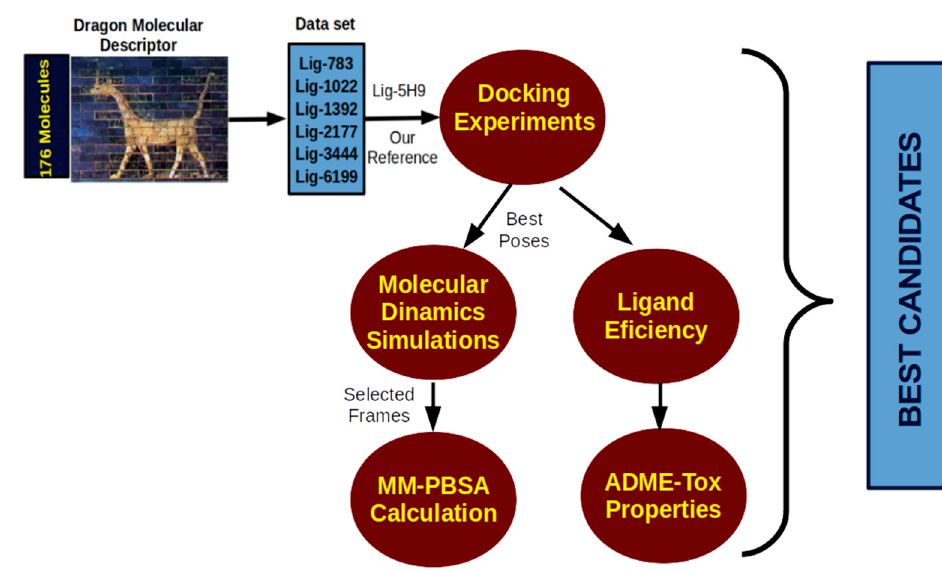
Figure 10. Computational protocol for the evaluation of possible antibacterial agents.